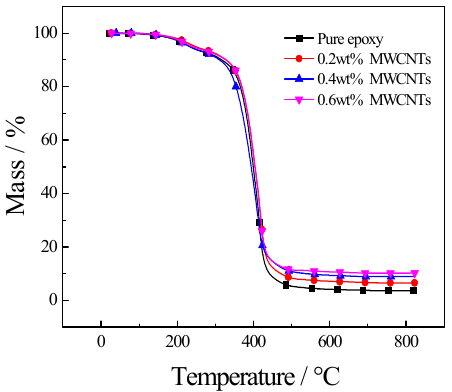
Figure 8. TGA curves of epoxy nanocomposites with the content of various PABA-modified MWCNTs.